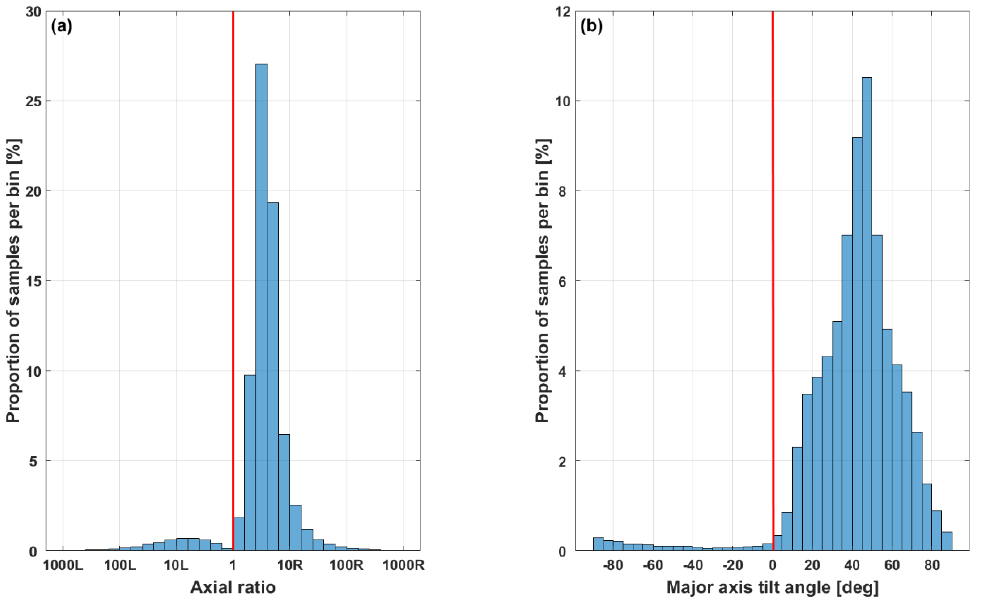
Figure 11. Hungary: 26 June, 23, 29 July, 1, 18, 20 August 2018, total 119.1 min at 6000 samples s − 1 . ( a ) Axial ratio histogram. Horizontal axis: axial ratio (logarithmic scale). Red center line: axial ratio = 1 (circular polarization). Left of center line: left ‐ hand elliptical polarization. Right of center line: right ‐ hand elliptical polarization. Vertical axis: proportion of samples per bin. ( b ) Tilt angle histogram. Horizontal axis: tilt angle (linear scale). Red center line: tilt angle = 0° (horizontal). Left of center line: negative tilt angle. Right of center line: positive tilt angle. Vertical axis: proportion of samples per bin.